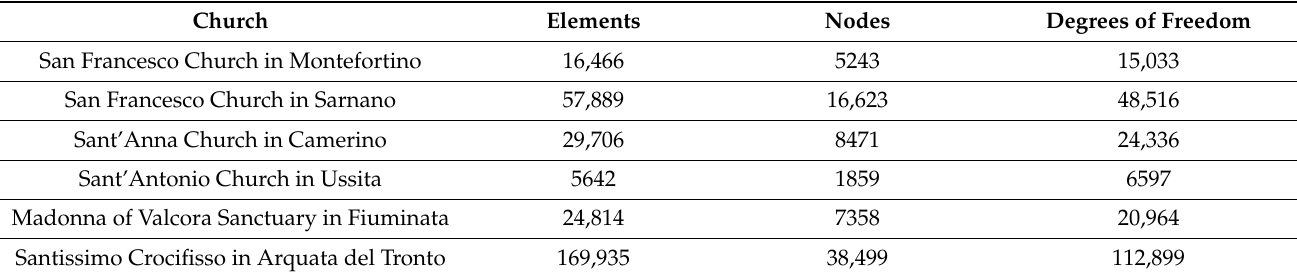
Table 1. Main characteristics of the numerical models of the six churches analyzed.